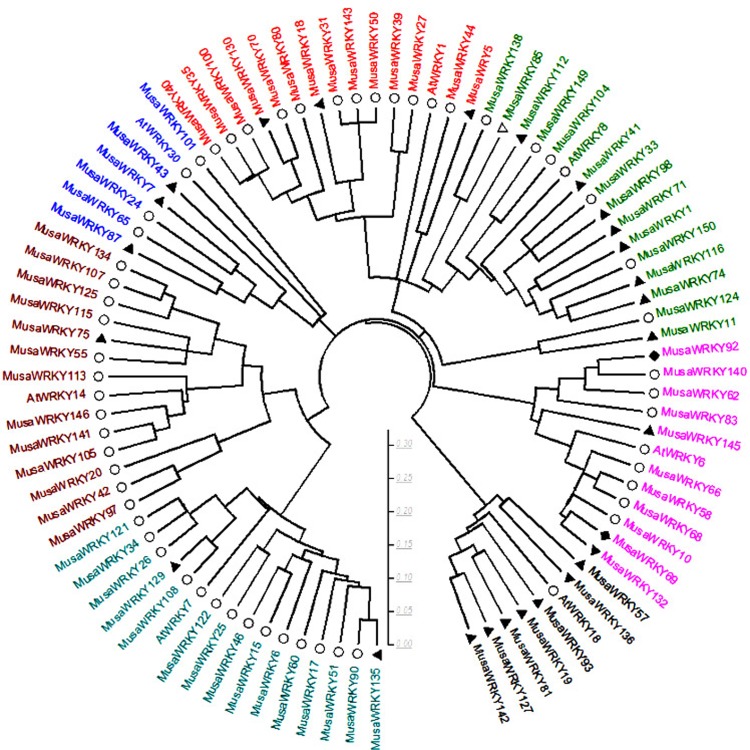
Unrooted phylogenetic tree representing relationships among WRKY domains of Musa and Arabidopsis.Amino acid sequences of WRKY genes were aligned with clustal W and 1000 bootstrap values in neighbor-joining method in MEGA 5.2.Branch name of sub trees are colored indicating different WRKY groups and subgroups. Triangle symbols indicated that significant expression in susceptible or resistant cultivars. Ο symbol shows that no genes were expressed, and arcs symbol showed that up-regulated in resistant and down-regulated in susceptible cultivar during nematode infection.